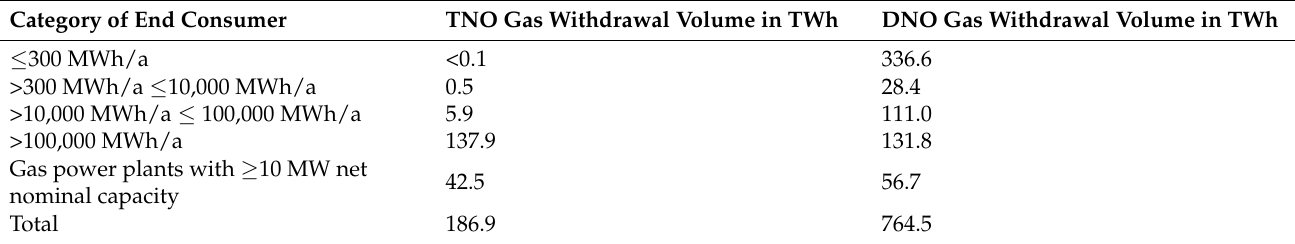
Table 1. Gas withdrawal volume in 2019 by category of end consumer